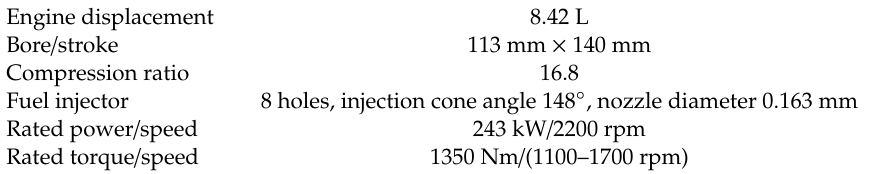
Figure 3. Test bench. Table 1. Engine specifications.